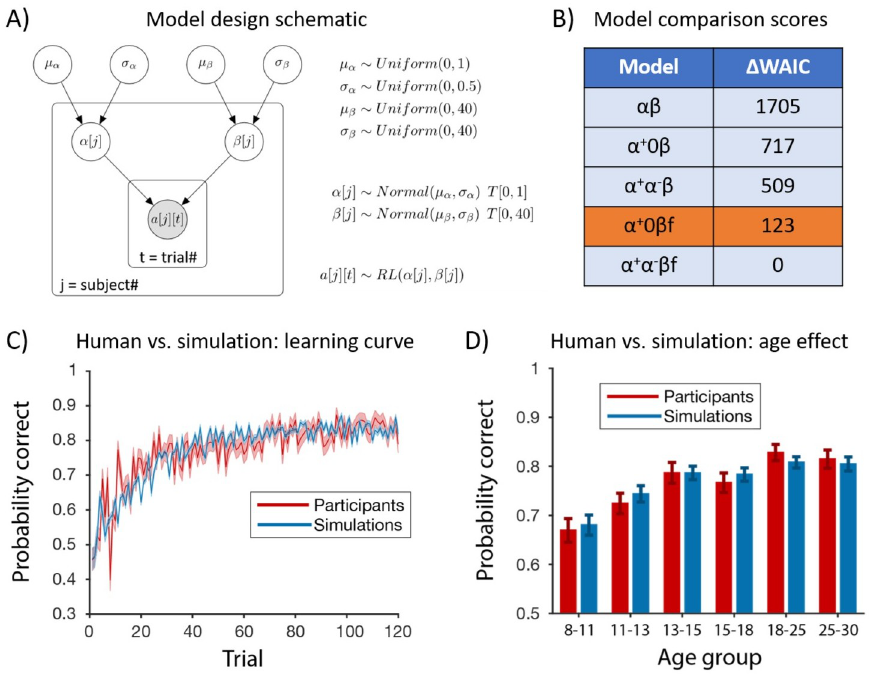
Fig 2. Hierarchical Bayesian modeling and model comparison. (A) We illustrate the hierarchical model design with the αβ model as an example, We assumed that parameters of individual participants came from the same group level distribution, which is truncated normal parametrized by the group-level mean and standard deviation ( μ α and σ α for α ; μ β and σ β for β ). The group-level mean and standard deviation followed weakly informative priors (uniform and bounded). The parameters for each individual participant are used in the likelihood of each action on every trial based on the αβ model. T [ m , n ] indicates truncation of distribution (e.g. the learning rate, α , is bounded by [0, 1]). The filled circle represented observed variable (in this case, participants’ choices on each trial); unfilled circles represented latent variables (in this case, group and individual model parameters). (B) We calculated WAIC for model comparison. Δ WAIC represents the difference between the WAIC of the considered model and the model with the lowest (i.e. best) WAIC. While the α + α − β f model had the lowest WAIC score, the α − parameter was not recoverable and showed signs of overfitting (see S1 Text: Model comparison extended). We thus focus on the α + 0 β f model. (C-D) We used fitted parameters from the α + 0 β f model to generate simulated trajectories. The simulated performance captures the average learning curve throughout the experiment (C), and replicates the age effect (D).